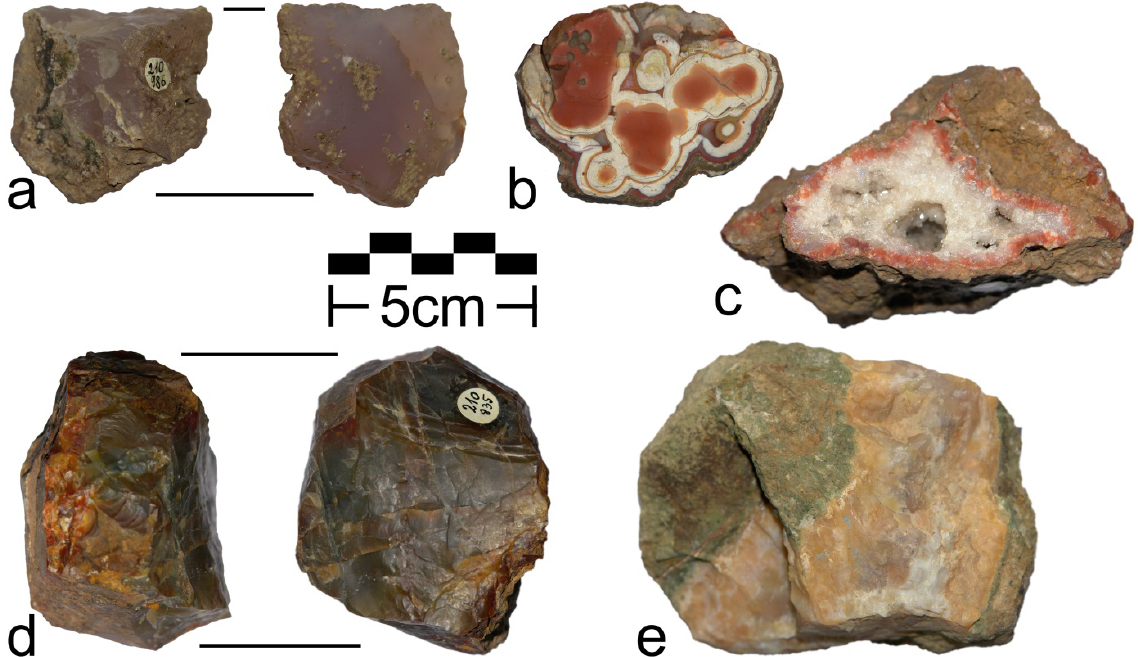
Figure 5. Agate samples from the study area. a) Brad Valley (north of Brad); b) at the edge of Brad; c) Dumbrava; d) near Brad towards Ruda; and d) near